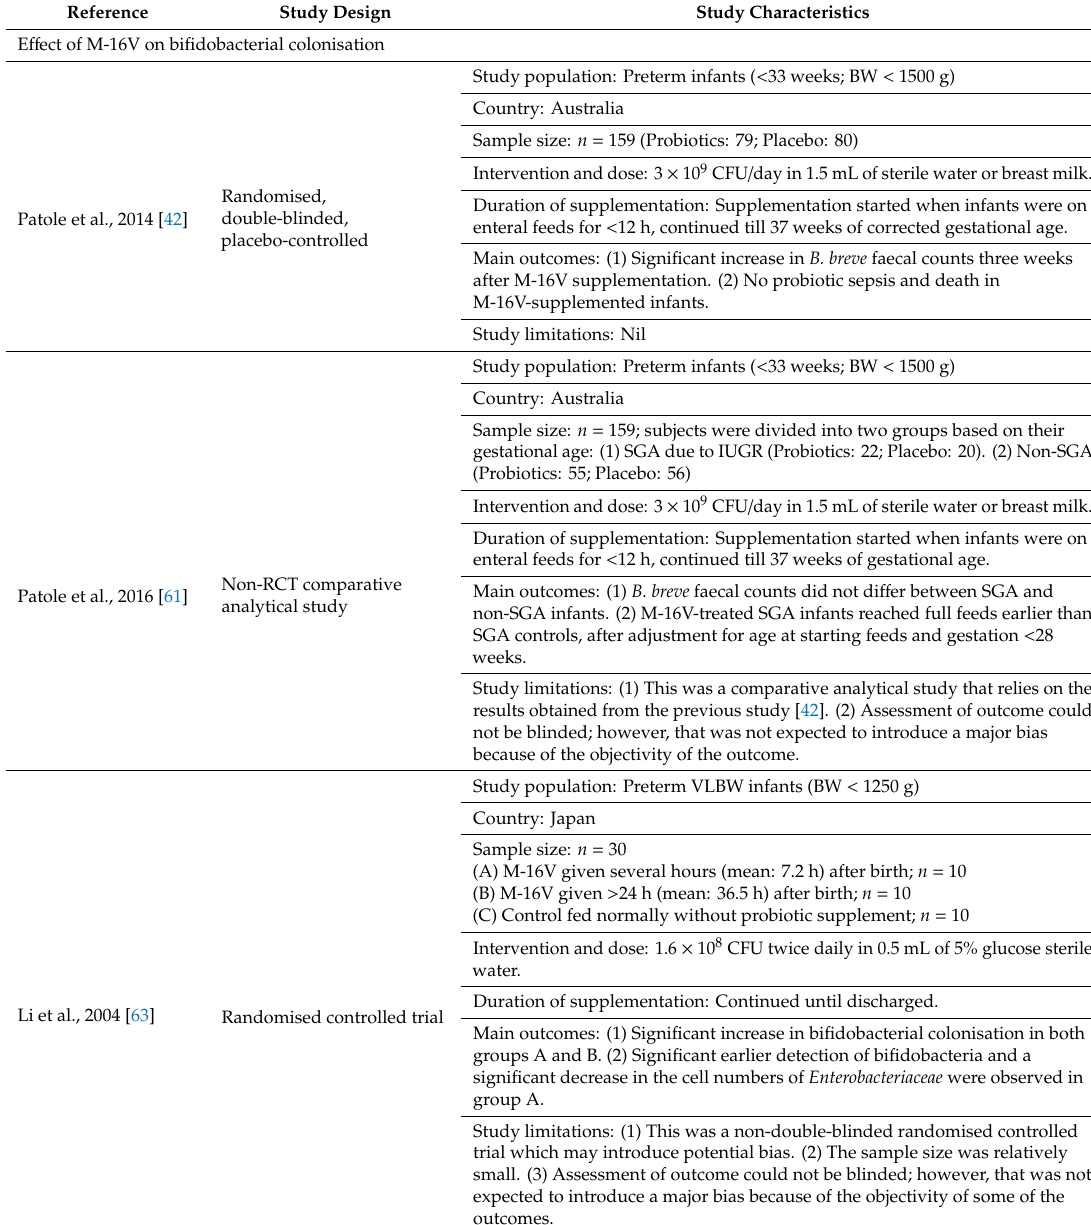
Table 1. Summary from clinical studies of the e ff ects of M-16V on premature birth